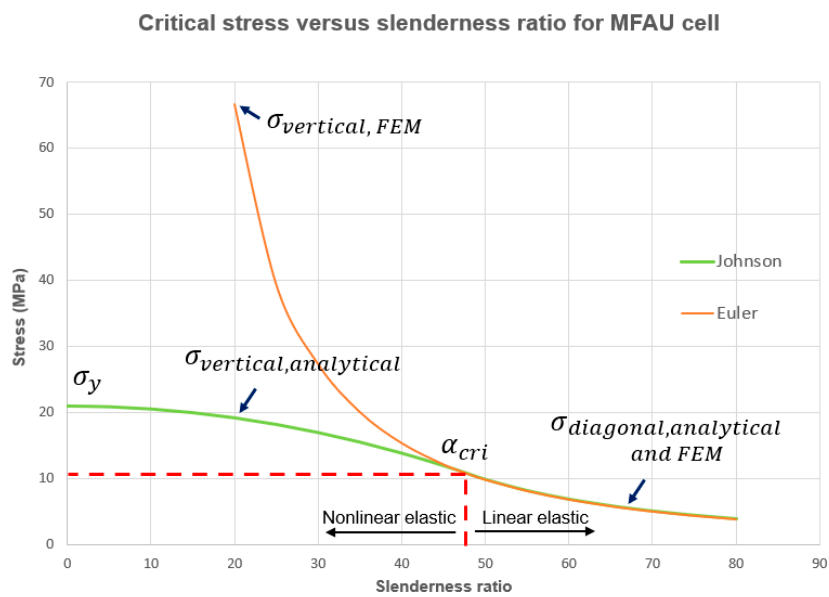
Figure 6. Stress–slenderness ratio construction of an MFAU cell failure line.